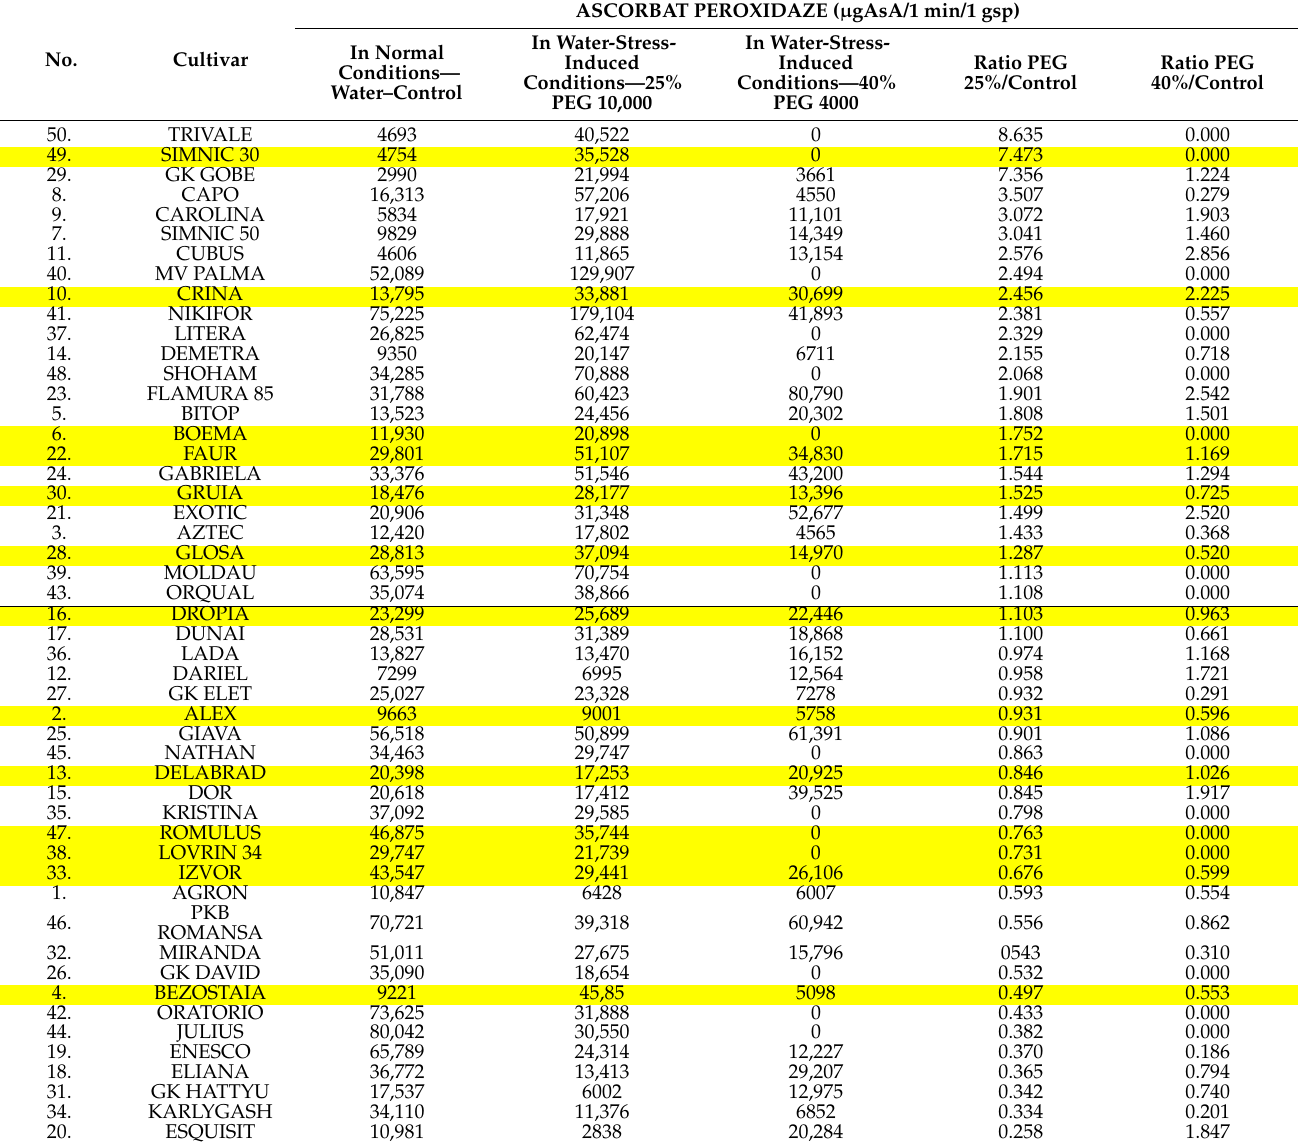
Table 2. The activity of ascorbat peroxidase in an assortment of 50 wheat cultivars analysed.